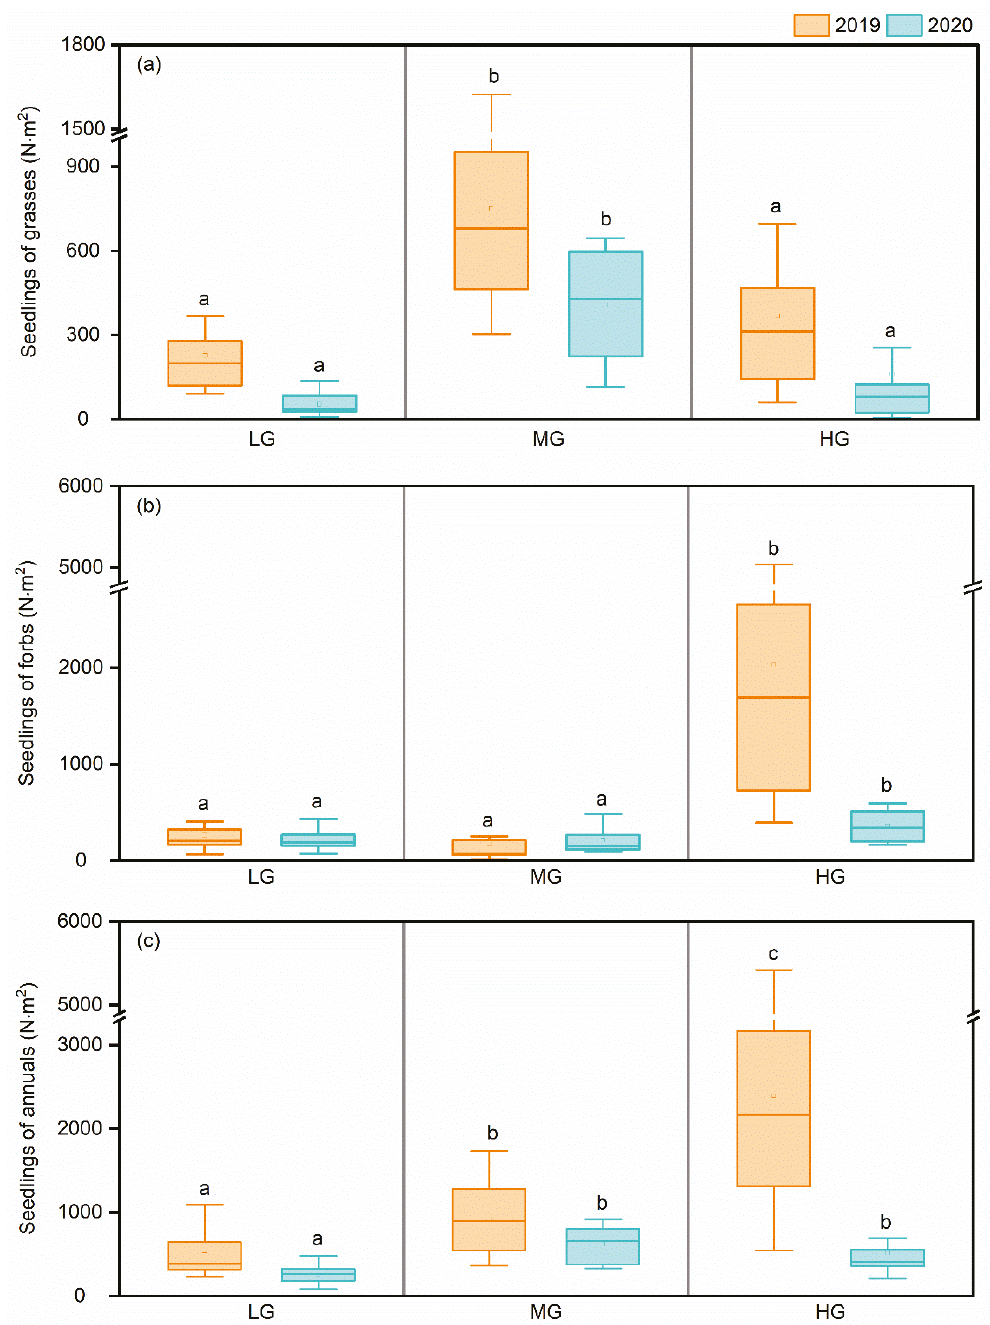
Figure 3. Total seedling emergence of annual grasses ( a ), annual forbs ( b ), and all annuals ( c ) under the different grazing intensities during contrasting wet and dry years. Different letters indicate significant differences ( p < 0.05) among the different grazing intensities in the same year.